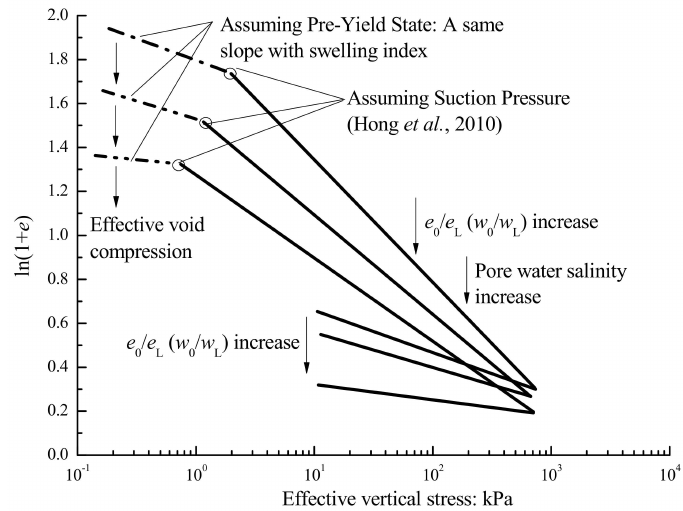
Figure 10. The conceptual diagram to specify the relationship between e 0 / e L and C cv or C sv